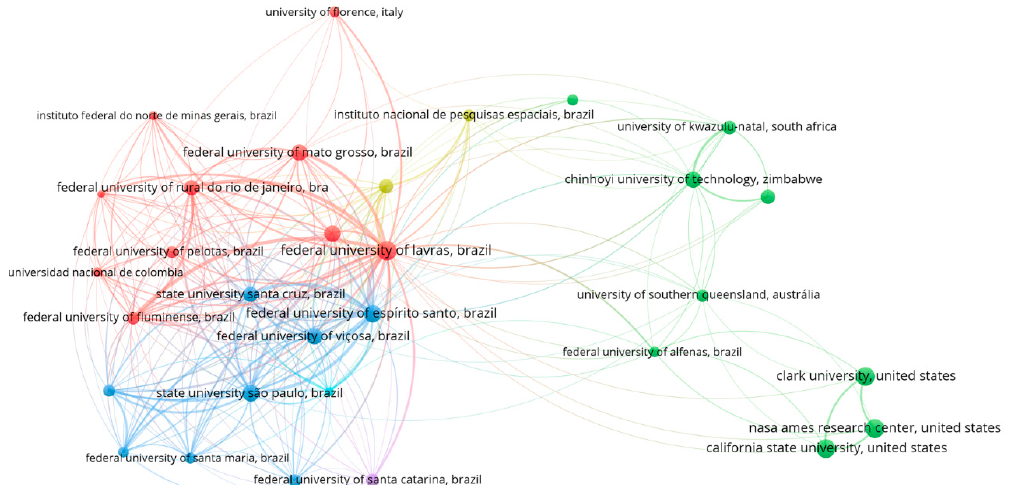
Figure 5. Scientific mapping network of educational and/or research organizations that produce knowledge about precision coffee growing. Red: the main institution was Federal University of Lavras. Yellow: “Company of technical as-sistance and rural extension of the state of Minas Gerais” and “National Institute for Space Research -I NPE”. Green:proximity between institutions from the United States of America and institutions from South Africa. Blue:exchange of research within the